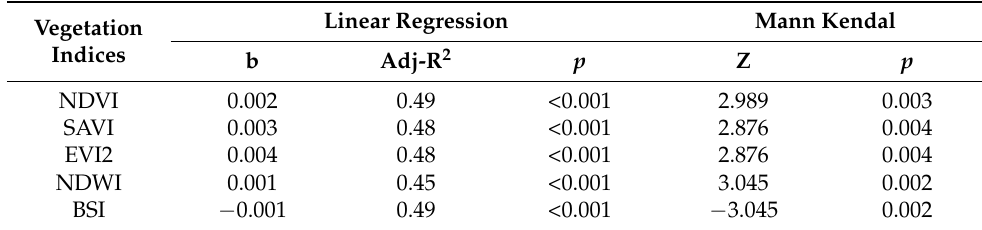
Table 5. Results of the linear regression between time and vegetation indices and Mann–Kendall test. Linear Regression Mann Kendal Vegetation Indices b Adj-R 2 p Z p NDVI 0.002 0.49 <0.001 2.989 0.003 SAVI 0.003 0.48 <0.001 2.876 0.004 EVI2 0.004 0.48 <0.001 2.876 0.004 NDWI 0.001 0.45 <0.001 3.045 0.002 BSI <0.001